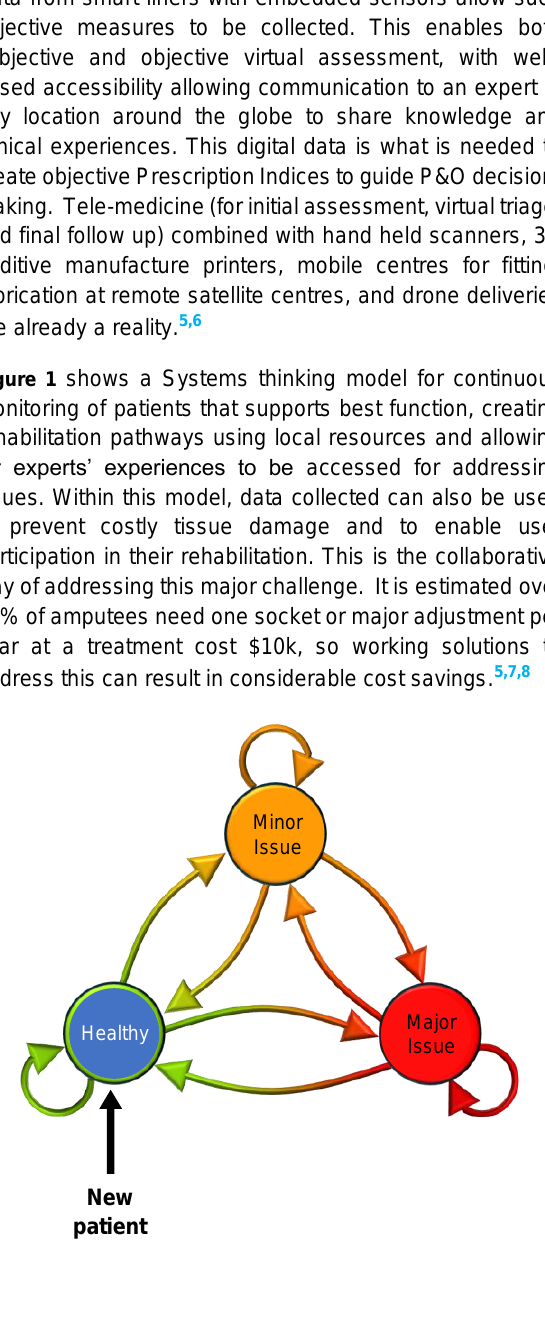
Figure 1 : Systems Thinking: three health states needing different resources. (Diagram from Blatchford